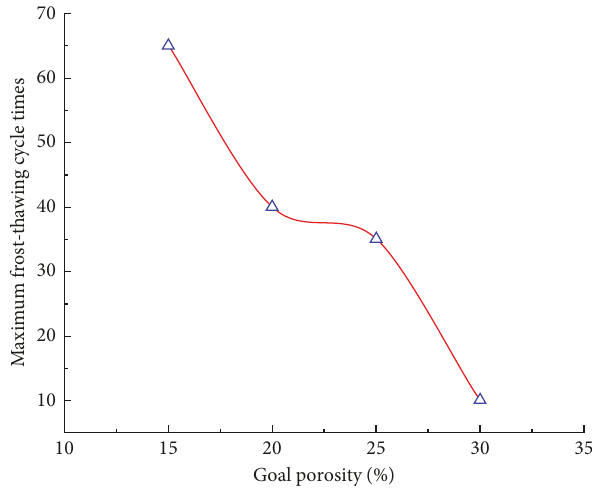
Figure 12: Relationship between the maximum cycle time of freeze-thawing and the porosity of the porous concrete.